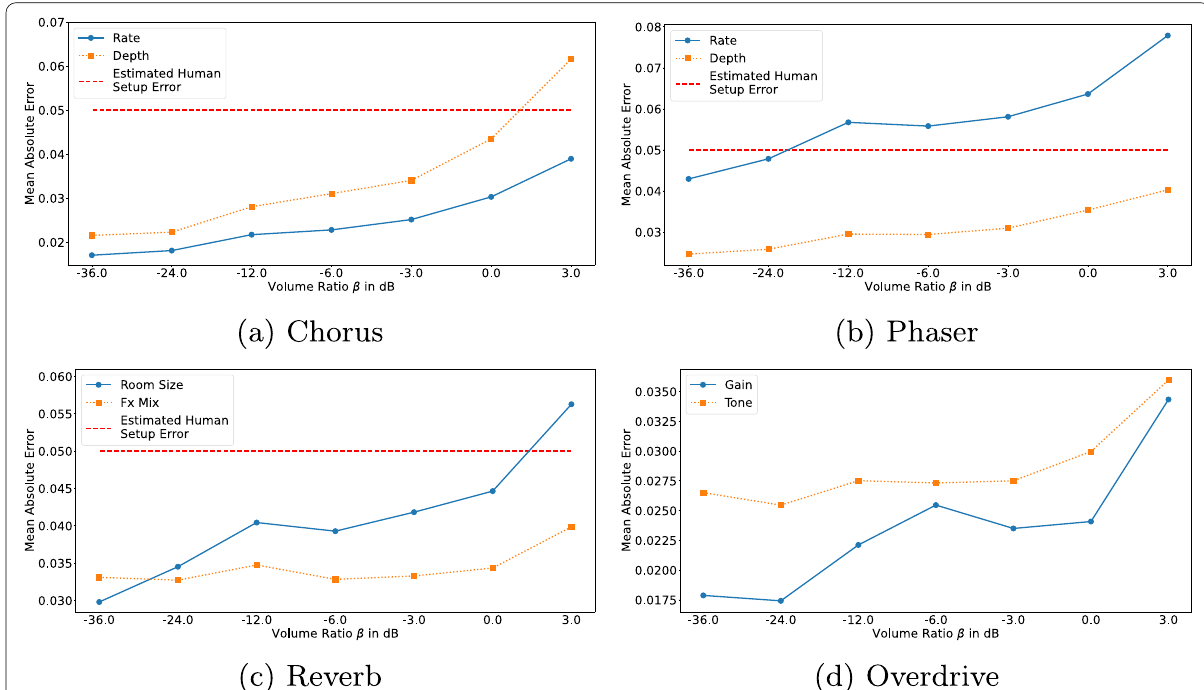
Fig. 12 Mean absolute error of the parameter extraction across mixing volume using mel-frequency cepstral coefficients for the a chorus, b phaser, c reverb, and d overdrive effect. The presumed human expert setup error of 0.05 was added as well, where appropriate, as a